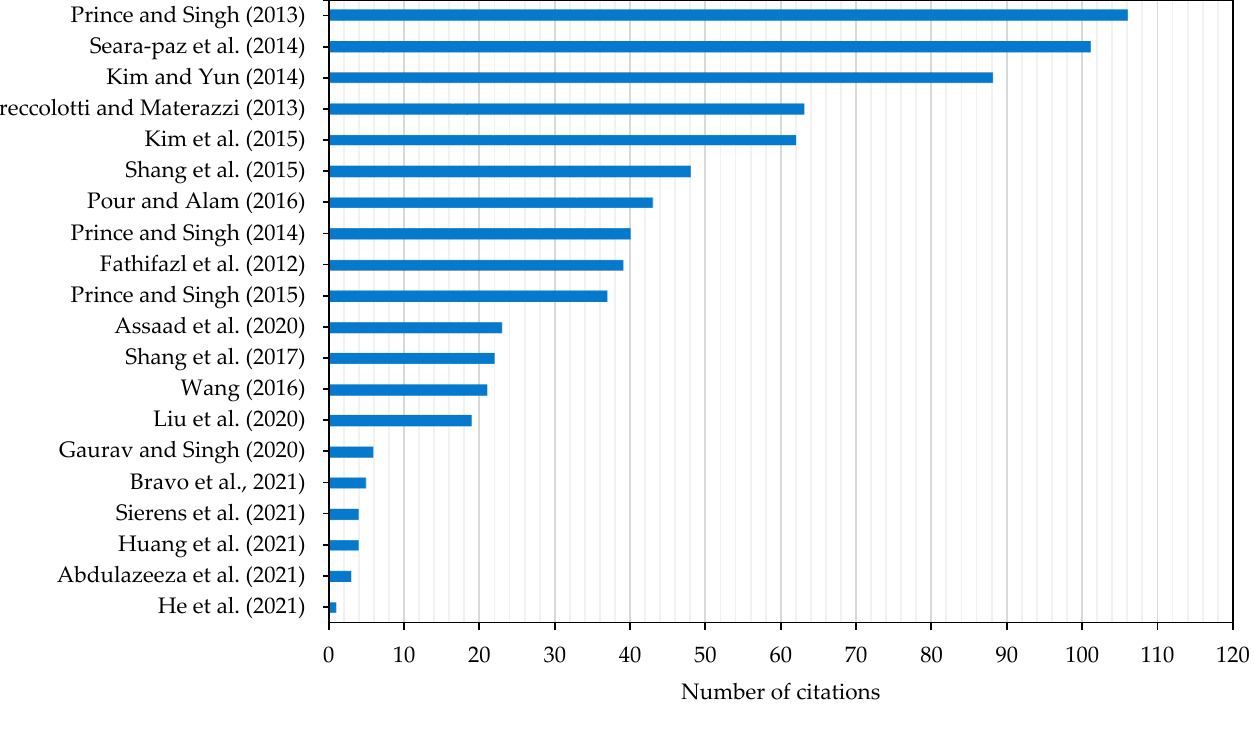
Figure 4. Relevance of the selected articles. Table 2. Classification of the journals by